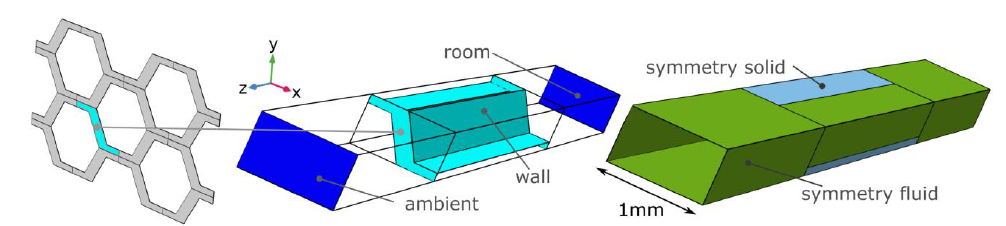
Figure 7. Boundary conditions and geometry parameters of the 3D model. Table 4. Boundary conditions; the normal n is outward-pointing. The auxiliary matrix variable K is